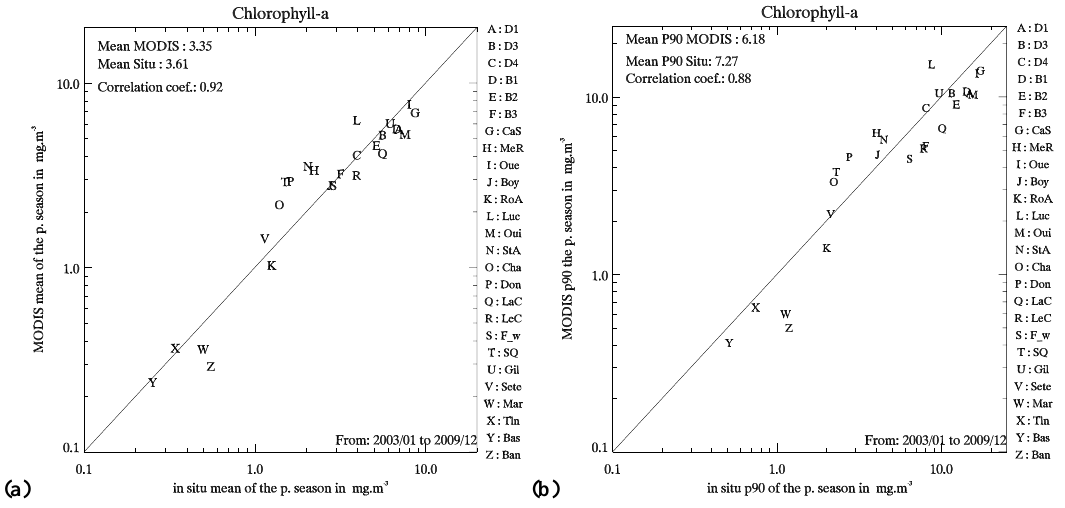
Fig. 6. Average (a) and P90 (b) of the MODIS and in-situ Chl for the productive season. The stations are represented by two or three characters corresponding to the codes defined in Fig. 1. The lowest Chl means and P90s are obtained for Bas (“Sud Bastia”), Tln (“22B Toulon gde rade”), Mar (“MARSEILLE FRIOUL”) located in the Mediterranean Sea. The highest levels are observed at Oue (“Ouest Loscolo”) and CaS (“Cabourg Shifted”) in the vicinity of the Vilaine (Southern Brittany) and Seine